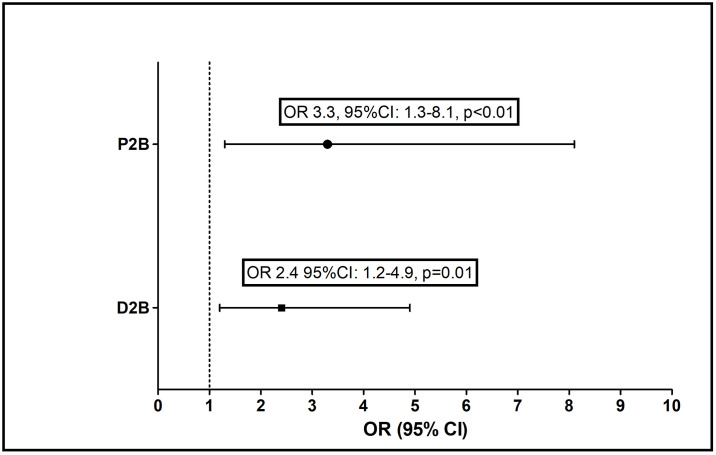
Adjusted* odds ratio for delayed reperfusion times.* Reference group: 2019 admissions; Adjusted to age, gender, ischemic heart disease, hypertension, Smoker, diabetes mellitus, and dyslipidemia. D2B: Door-to-Balloon, P2B: Pain-to-Balloon.